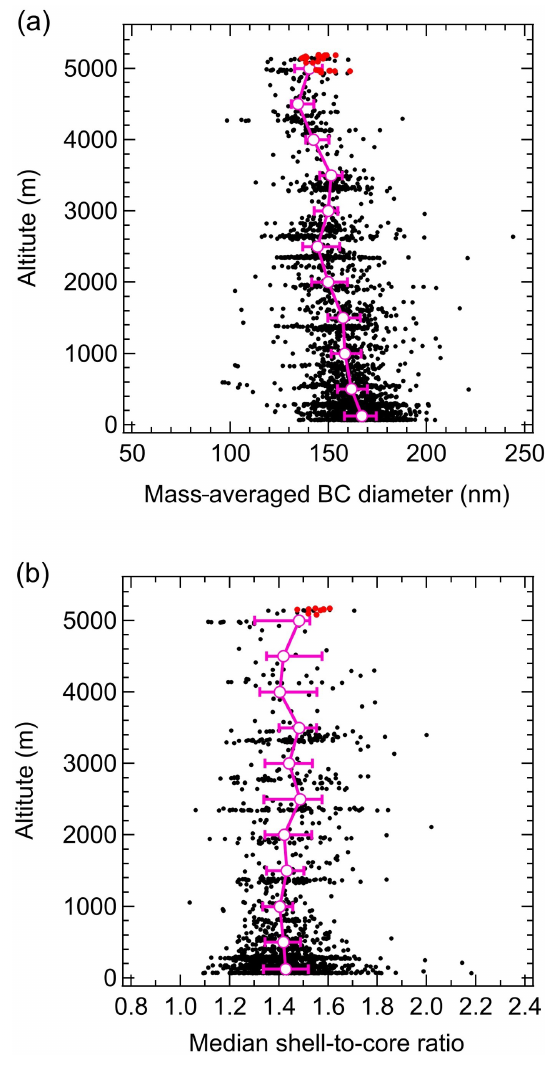
Figure 8. (a) Vertical profile of mass-averaged diameters of BC ( D BC ). Closed circles denote 1min data that were calculated from 1min BC mass concentrations ( M BC ) and BC number concentra- tions using Eq. (1). Median values and 25%–75% ranges are also shown. Data points shown in red (the enhanced M BC data points shown in red in Fig. 2a) were likely influences by biomass burning emissions. Panel (b) is the same as (a) but for the median shell-to- core diameter ratios for particles with a mass equivalent BC diame- ter (core diameter) of 180–192nm.